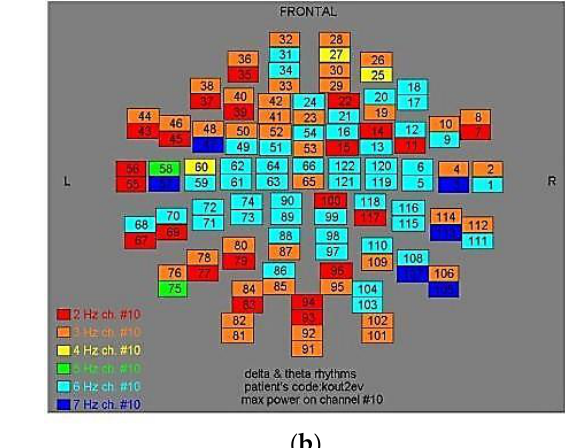
( b ) Figure 3. Dominant frequency color mapping for patient #2, before ( a ) and after ( b ) magnetic stimulation.